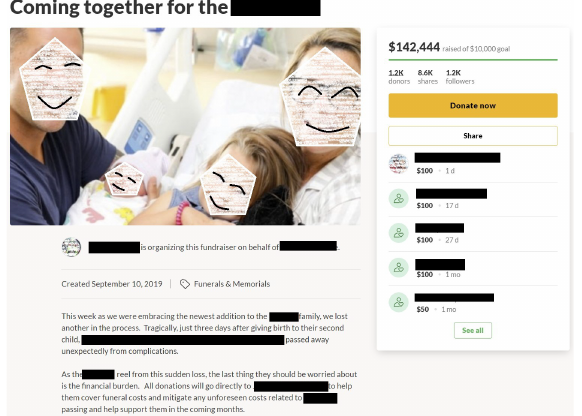
Fig. 1 A campaign on GoFundMe.com (recognizable faces and names are masked to preserve privacy).